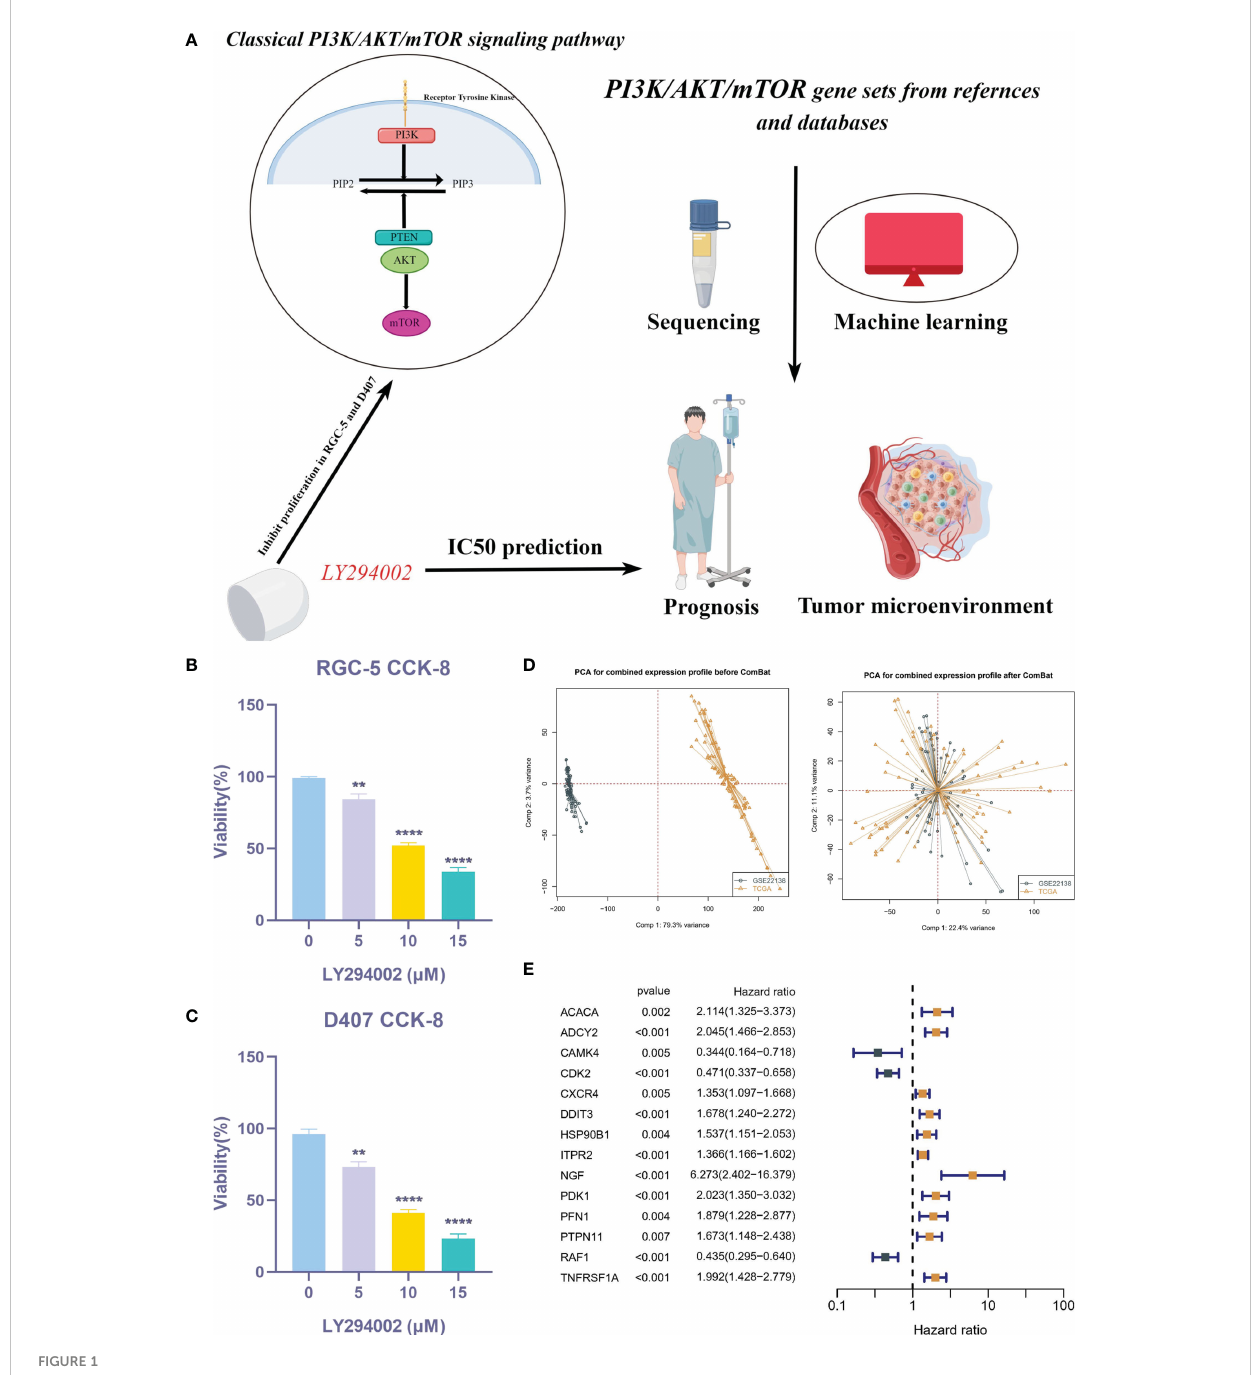
FIGURE 1 Expression of PRGs in UVM and univariate Cox analysis. (A) Flow chart of this study. (B, C) CCK-8 assay. (D) PCA analysis in TCGA cohort and GSE22138 cohort. (E) The univariate Cox analysis of PRGs in UVM. ** P < 0.01, **** P <